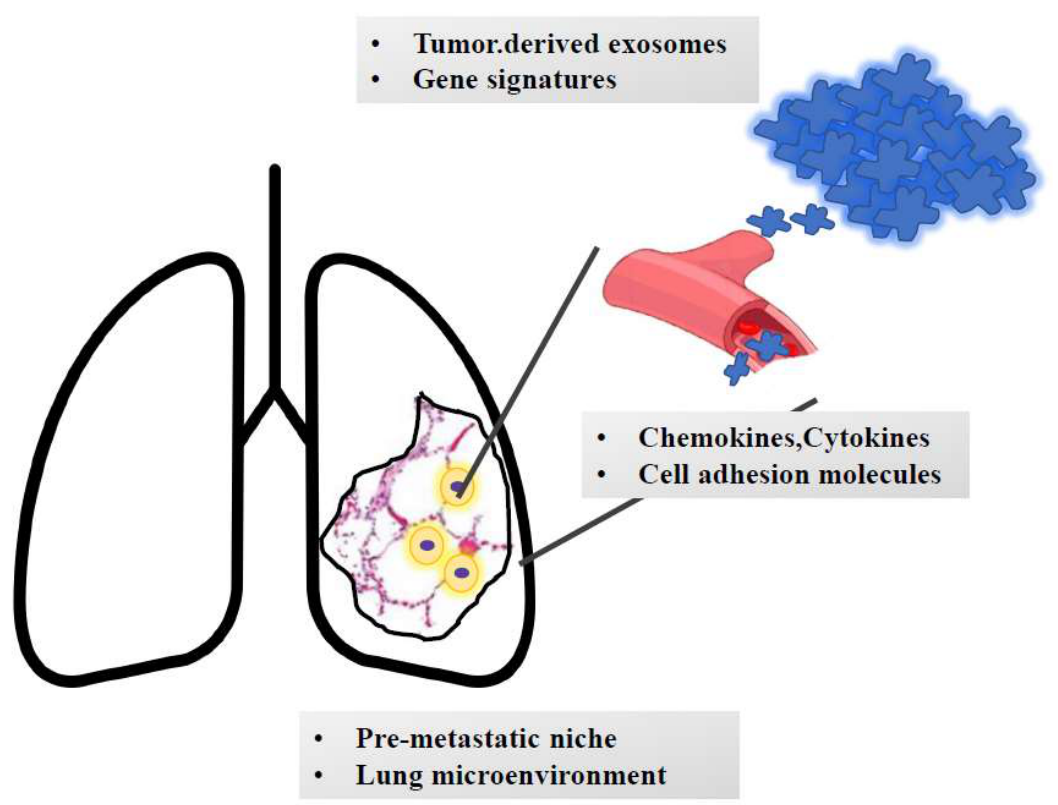
Figure 3. The journey of metastatic clones towards the lungs. The growth of metastatic masses into the lung parenchyma is orchestrated by tumor-derived signals (e.g., exosomes and genetic signatures). Once detached from the primary mass, metastatic clones invade blood (or lymphatic) vessels. Based on the interaction with adhesion molecules and based on the cross talk with chemokines and cytokines, cells reach the lung parenchyma and extravasate and colonize the pre-metastatic niche. Here, they undergo an epithelial-to-mesenchymal transition and interact with the surrounding stroma, which contributes to cell survival and growth. Moreover, smoke-induced chronic inflammation and hypoxia promote macrophage recruitment and immunotolerance.